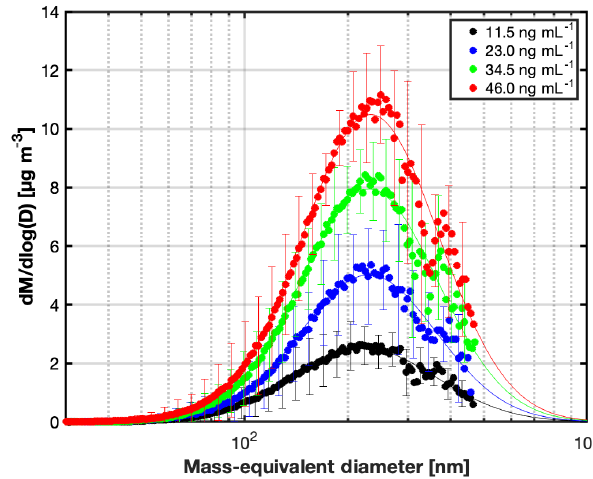
Figure 2. Particle mass size distributions of the fullerene soot sus- pensions used to characterize the Marin-5 nebulizer. The measure- ments were conducted with the SP2, which has an upper size limit of 560nm in the present study. Results from lognormal fits are rep- resented by the thin